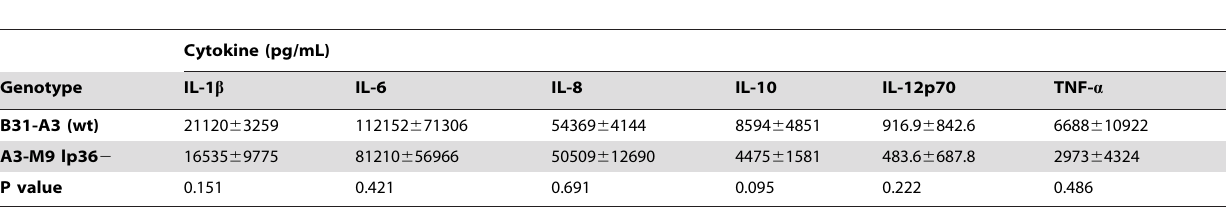
Table 3. Pro- and anti-inflammatory cytokine profiles elicited by B. burgdorferi B31-A3 and A3-M9 lp36 2 .